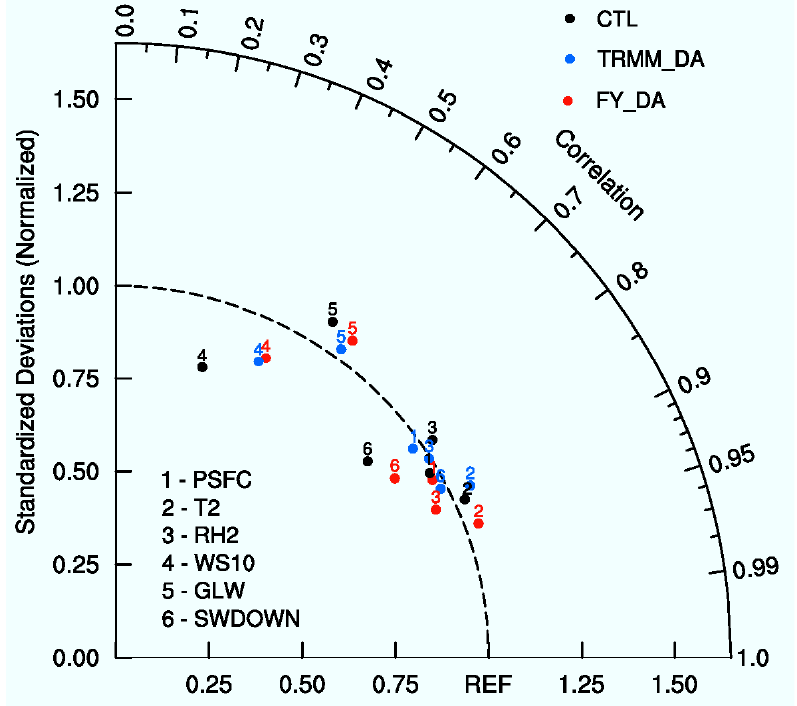
Figure 11. Taylor diagram of other atmospheric variables.